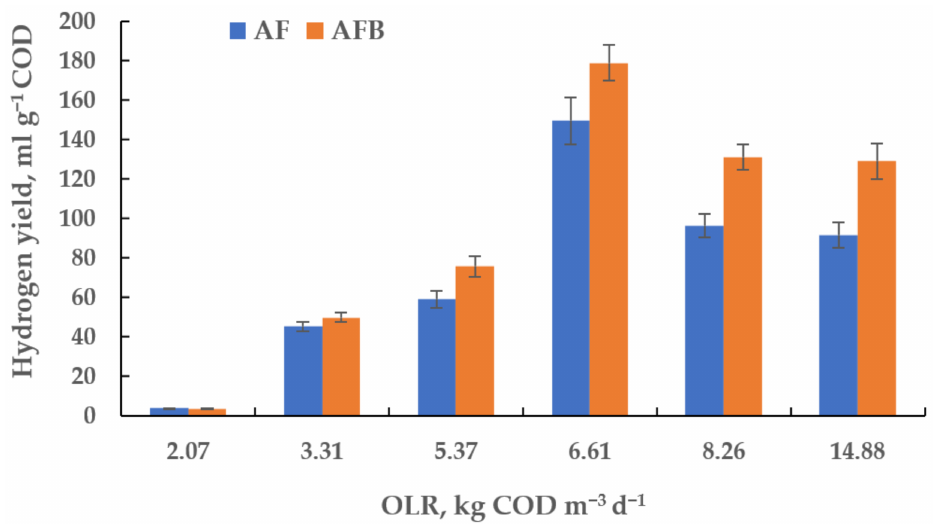
Figure 6. Dependence of the hydrogen yield on the organic loading rate (OLR) for the anaerobic filter (AF) and anaerobic fluidized bed (AFB).